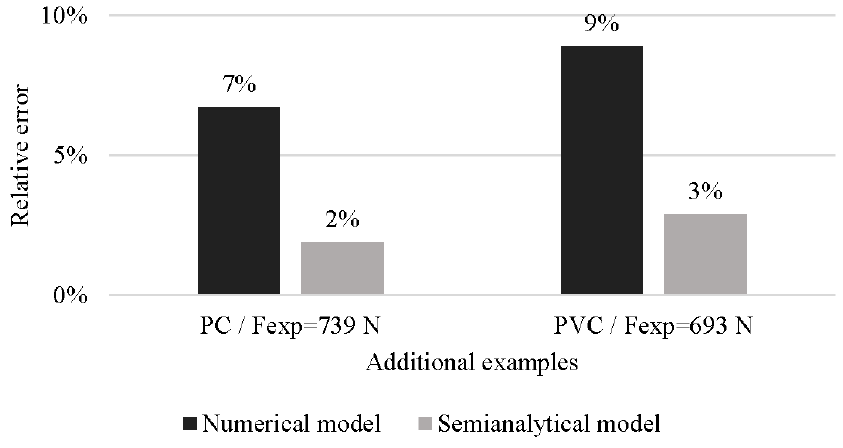
Figure 9. Relative error of the estimation for additional tests. Process conditions: Cone shape, α = 60°, D = 10 mm and Δz = 0.8 mm.